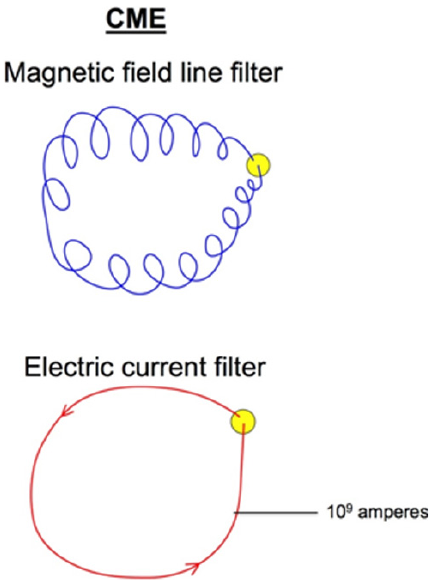
Fig. 24. The two views (magnetic field lines or electric currents) of a CME.